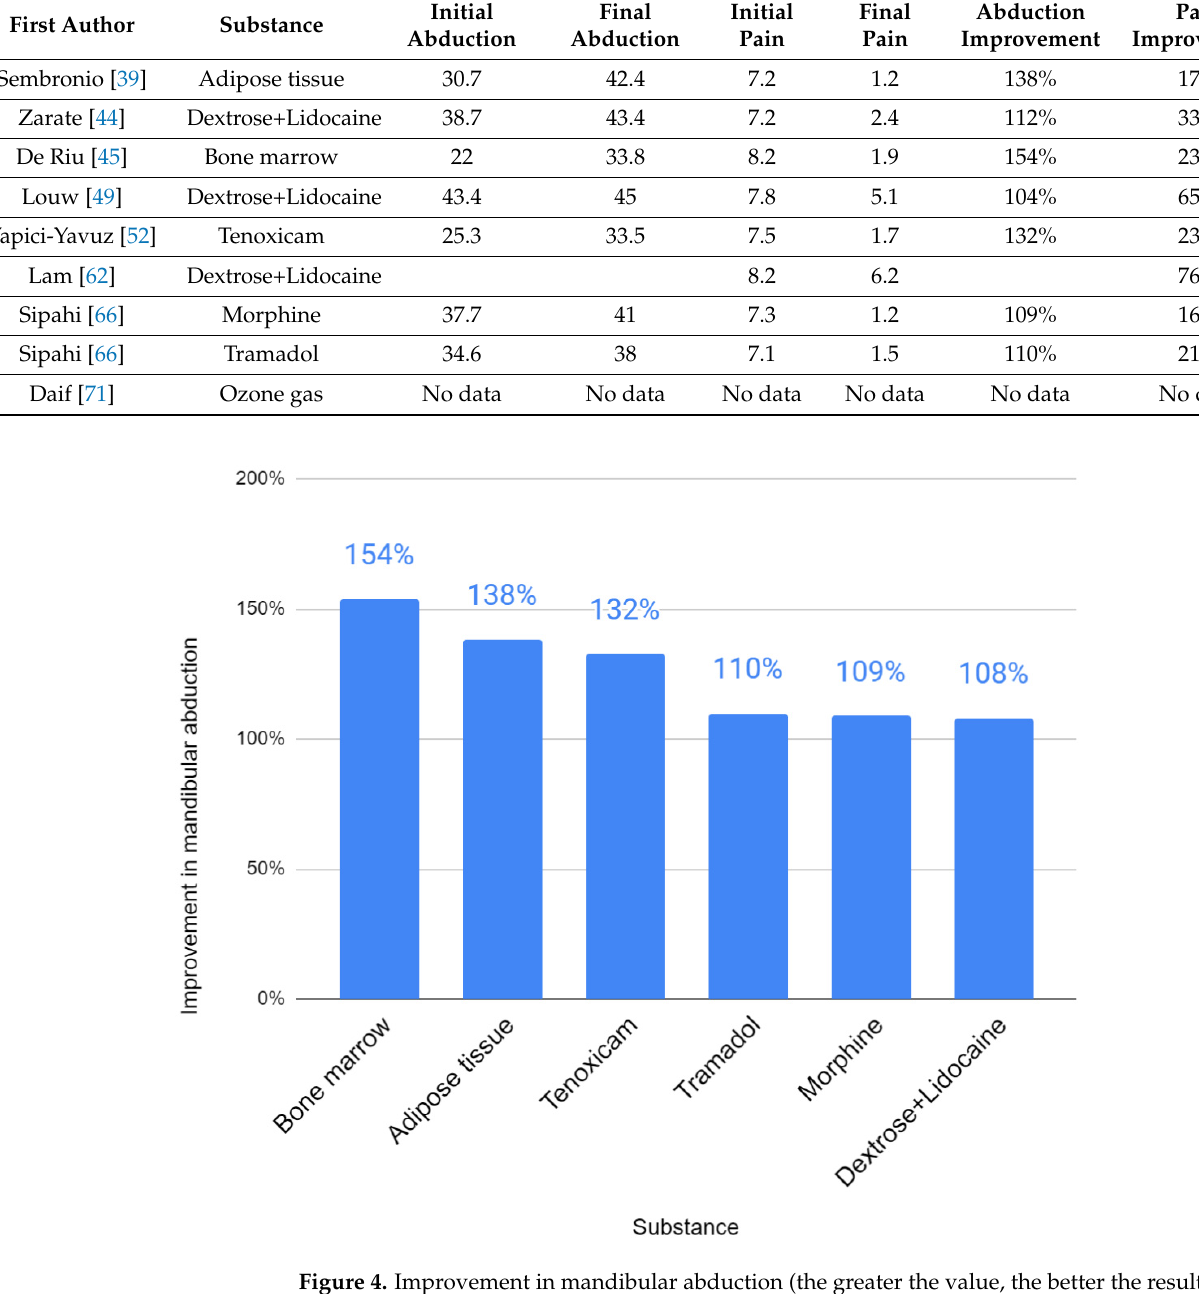
Table 5. Quantitative analysis.